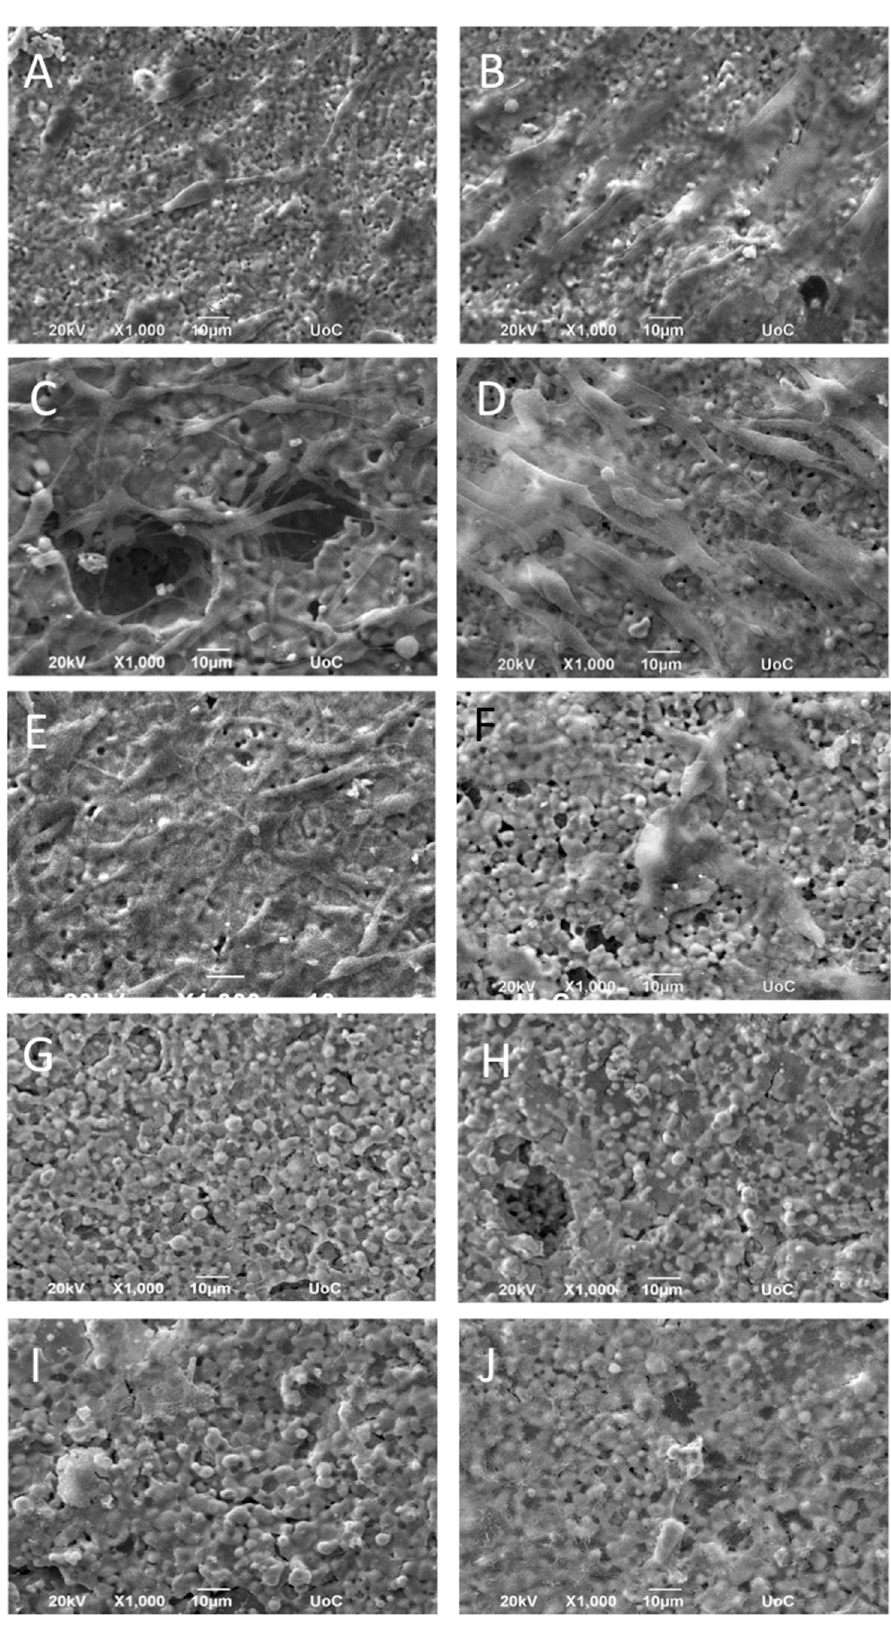
Figure 6. SEM images illustrating MC3T3-E1 cell adhesion and morphology on ZrO 2 (100) ( A , B ), ZrO 2 (75)MgO(25) ( C , D ), ZrO 2 (50)MgO(50) ( E , F ), ZrO 2 (25)MgO(75) ( G , H ), and MgO(100) ( I , J ) ceramics after 2 (left panel) and 14 days (right panel) in culture at a magnification of 1000-fold. Scale bars represent 10 µm.